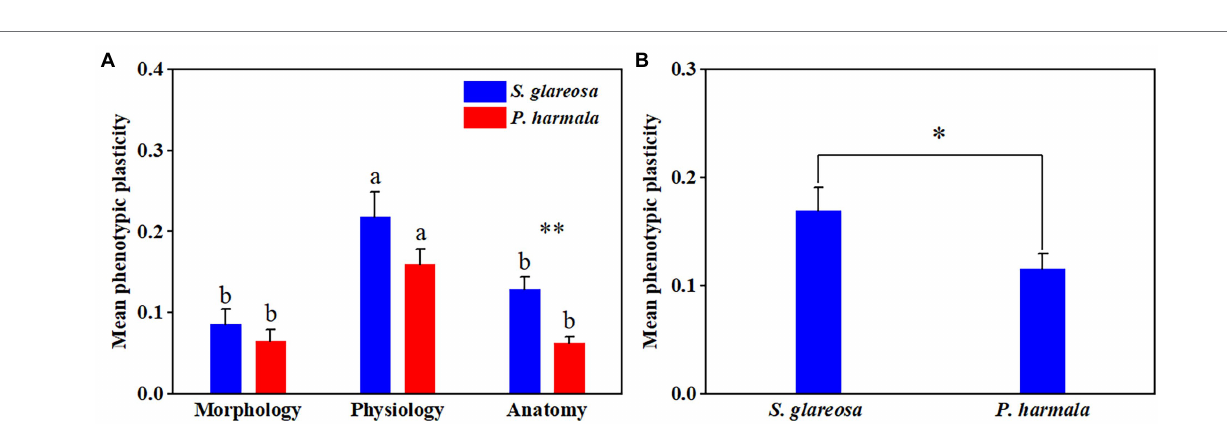
FIGURE 5 | Mean phenotypic plasticity indexes of all traits of S. glareosa and P. harmala under different N treatments divided by trait types. (A) Phenotypic plasticity indexes of morphological traits; (B) phenotypic plasticity indexes of physiological traits; and (C) phenotypic plasticity indexes of anatomical traits. Different lower-case letters represent significant differences within each treatment for each species ( p < 0.05). Asterisk represents significant differences between S. glareosa and P. harmala ( p < 0.05).